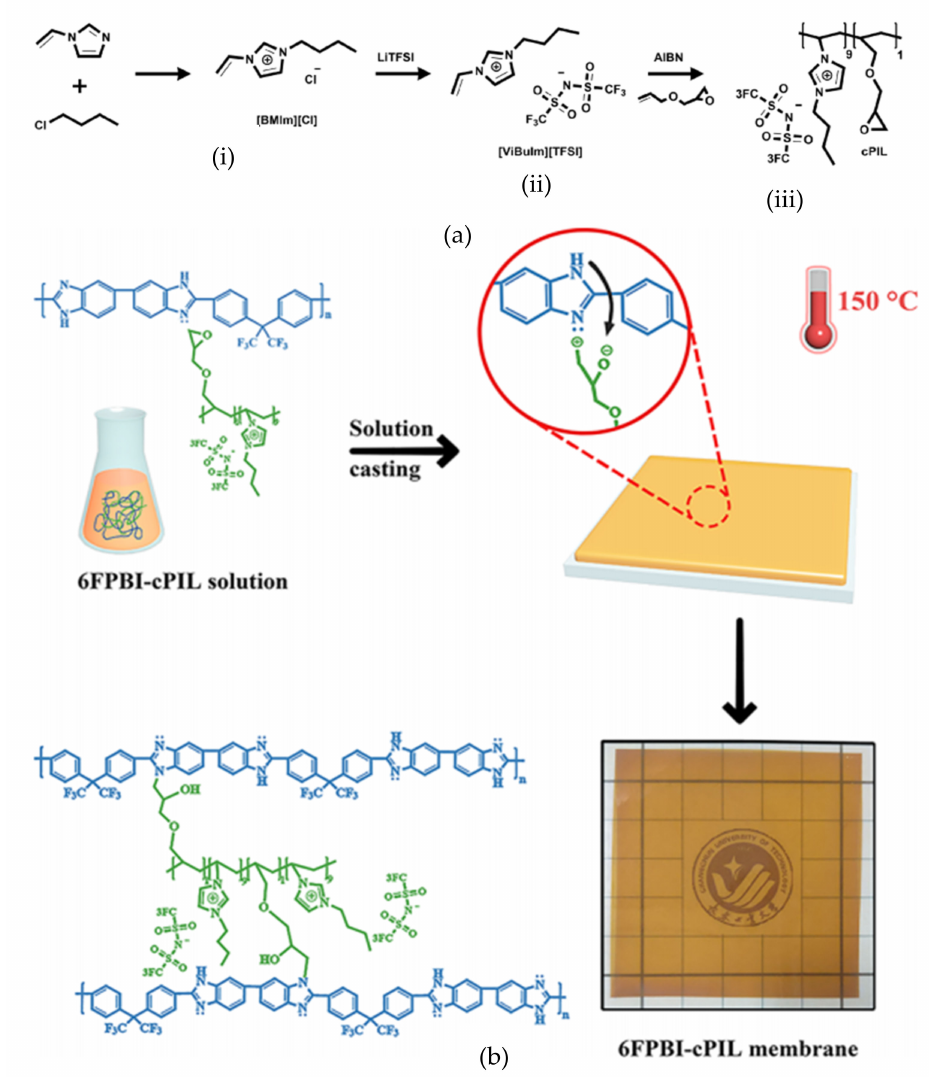
Figure 10. Schematic preparation of 6FPBI-cPIL membrane with ( a ) preparation of cross-linkable polymeric ionic liquid via ( i ) synthesis of [ViBuIm]Cl, ( ii ) anion exchange reaction to form [ViBuIm][TFSI] and ( iii ) free radical polymerization of [ViBuIm][TFSI] with allyl glycidyl ether to form cPIL. ( b ) Preparation of 6FPBI-cPIL membrane via a solution casting method